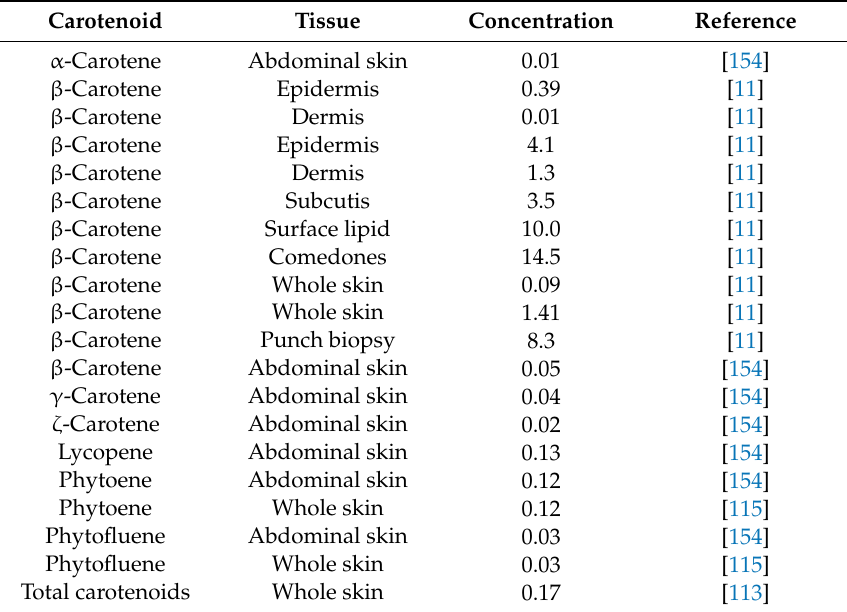
Table 4. Carotenoid concentrations reported in human skin (nmol /